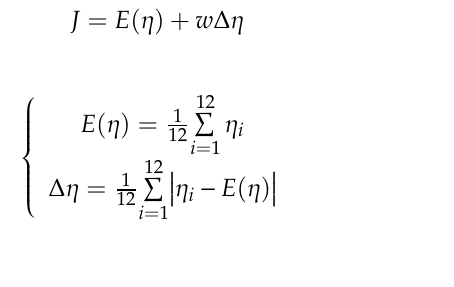
Table 2. E ffi ciency symbols in the di ff ering landing